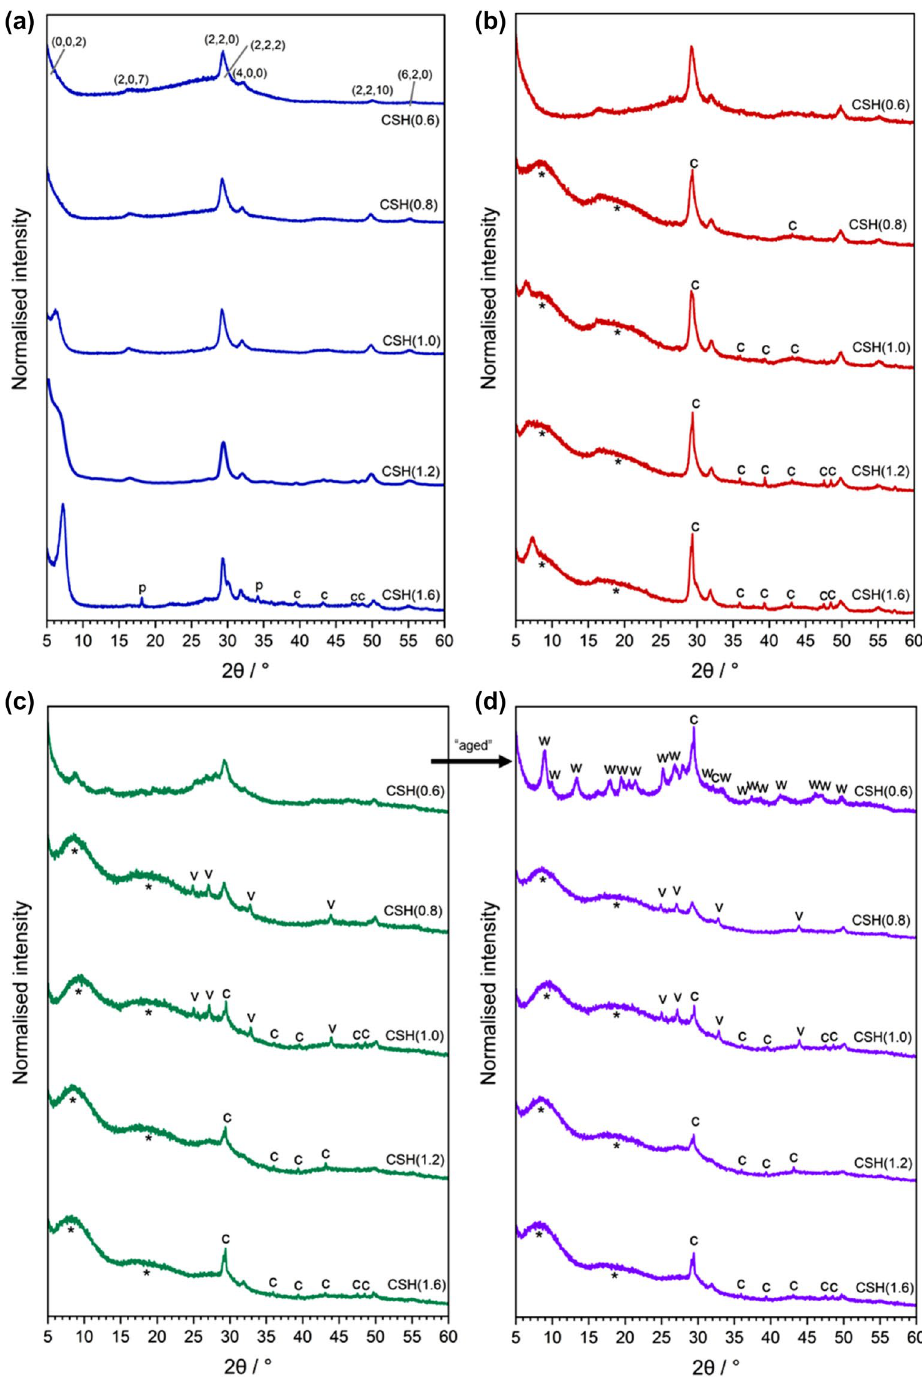
Figure 3. X-ray diffraction patterns of C–S–H phases. ( a ) before contact with U(VI) nitrate, indexed as C–S– H(I)/tobermorite (PDF card no 00–045-1480); ( b ) 0.5 mM U(VI)-contacted C–S–H phases; ( c ) 10 mM U(VI)- contacted C–S–H phases and; ( d ) 1 month aged 10 mM U(VI)-contacted C–S–H phases. Where c = calcite (CaCO 3 ; PDF card no. 01-078-4614); p = portlandite (Ca(OH) 2 ; PDF card no 04-006-9147); v = vaterite (PDF card no. 04-017-8634); w = “Ca-weeksite” (i.e. Ca 2 (UO 2 ) 2 Si 6 O 15 ·10H 2 O; PDF card